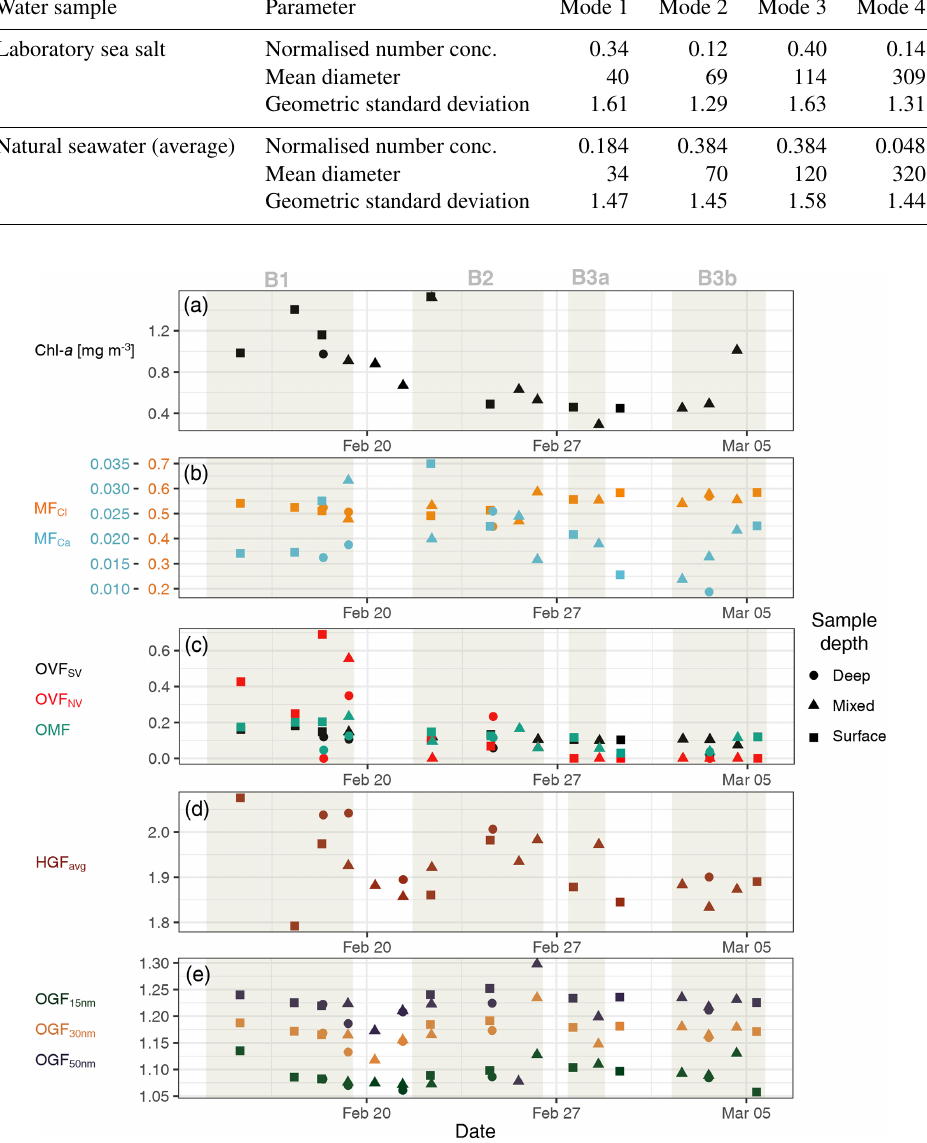
Figure 5. Summary of nascent SSA properties. Chl a time series included for context on phytoplankton bloom conditions (a) . Mass fractions (MF) of Cl − and Ca 2 + (multiplied by 20) relative to total inorganic mass concentrations measured using IBA on filter samples (b) . VH- TDMA OVF SV , OVF LV and FTIR/IBA-derived PM 1 OMF from filter samples (c) . HGF measured using VH-TDMA (d) ; organic growth factor measured using UFO-TDMA (bottom